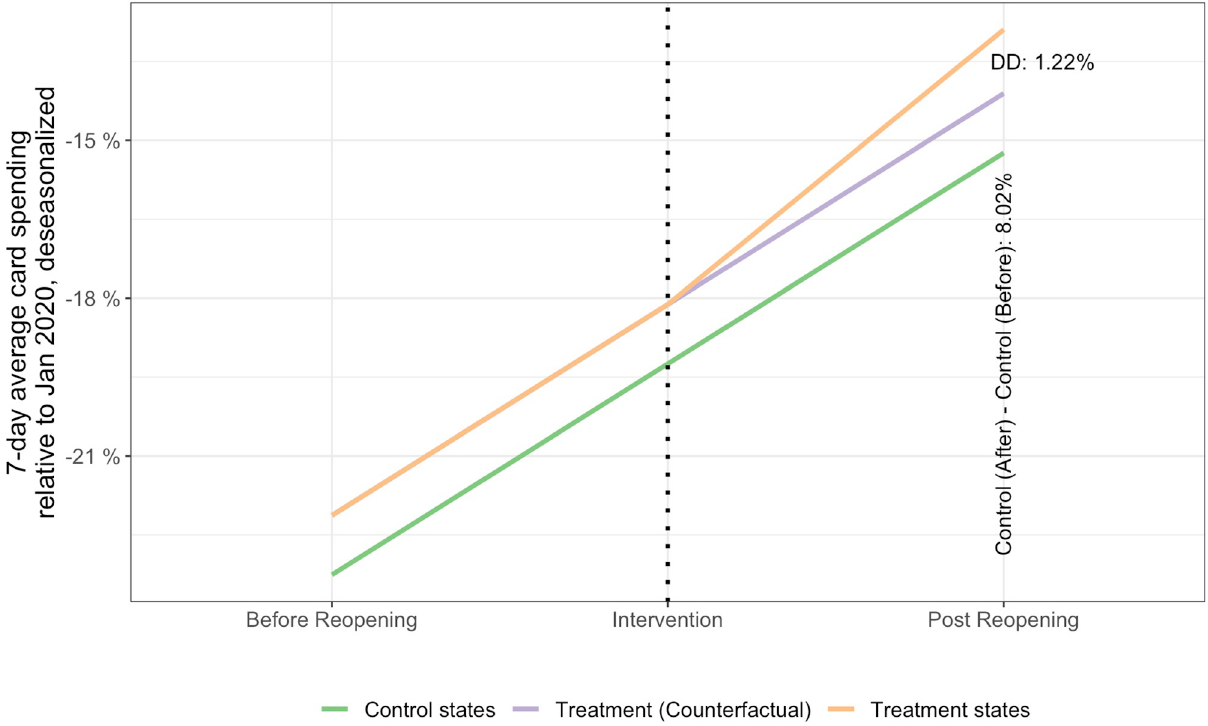
Fig 5. Average spend ( t ) (overall change in consumer card spending relative to January 2020) of states that reopened in the week of April 20 th -27 th 2020, compared to states that did not reopen. The groups of states “treatment” and “control”, as well as the periods “Before Reopening” and “Post Reopening” are described in section 3.5. Y control ; before ¼ (cid:0) 23 : 3% , Y control ; after ¼ (cid:0) 15 : 24% , Y reopened ; before ¼ (cid:0) 22 : 1% , Y reopened ; after ¼ (cid:0) 12 : 9% .